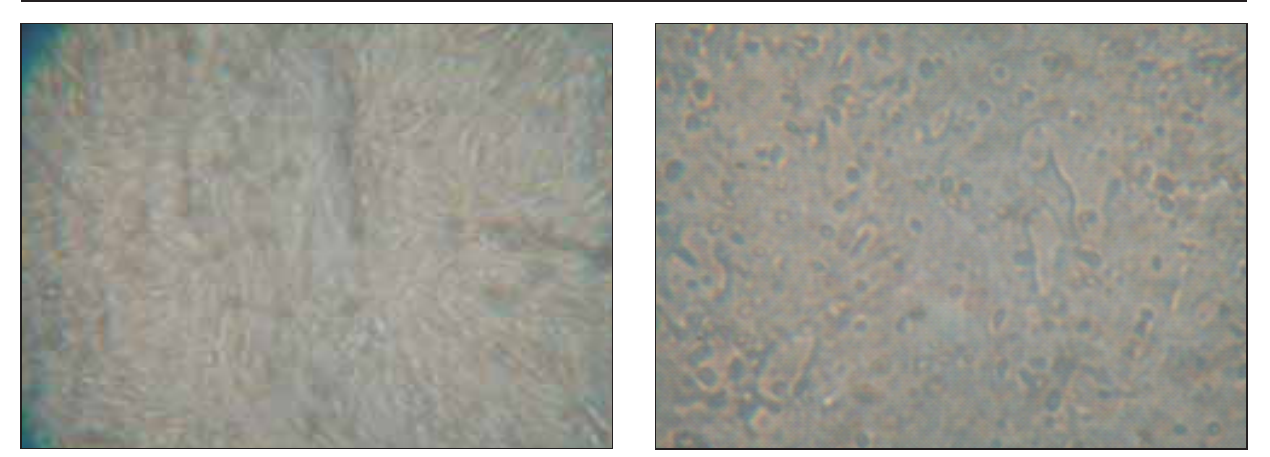
Figure-1: MDBK cells Healthy 10X, unstained. Figure-2: MDBK cells infected with BHV-1 virus at 96 h post infection showing CPE. (rounding, syncitia and vacuolation) 10X, unstained.